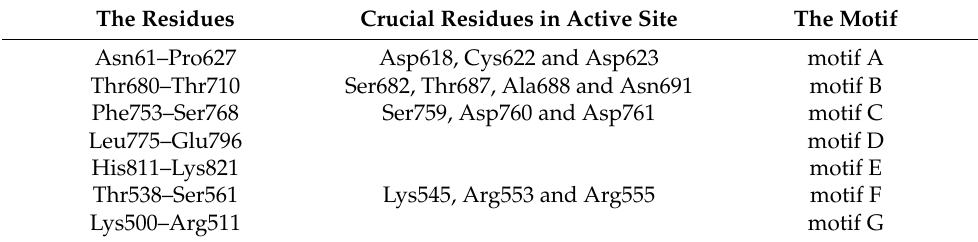
Table 1. The residues of seven critical catalytic motifs